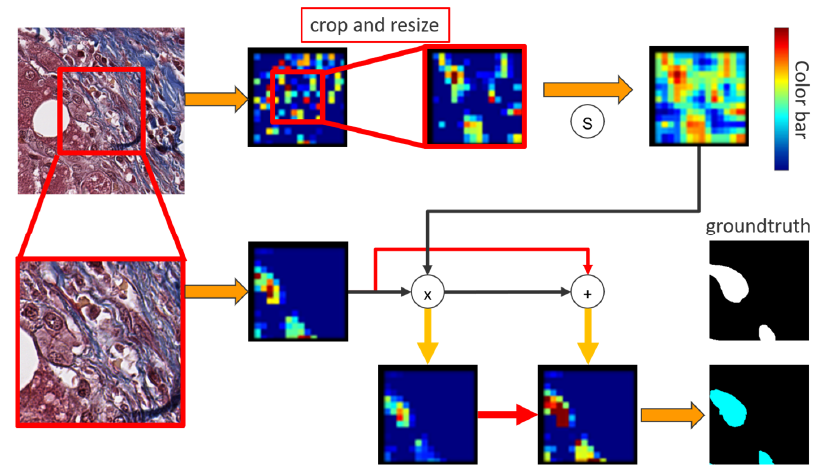
Figure 6. The attention method visualization.